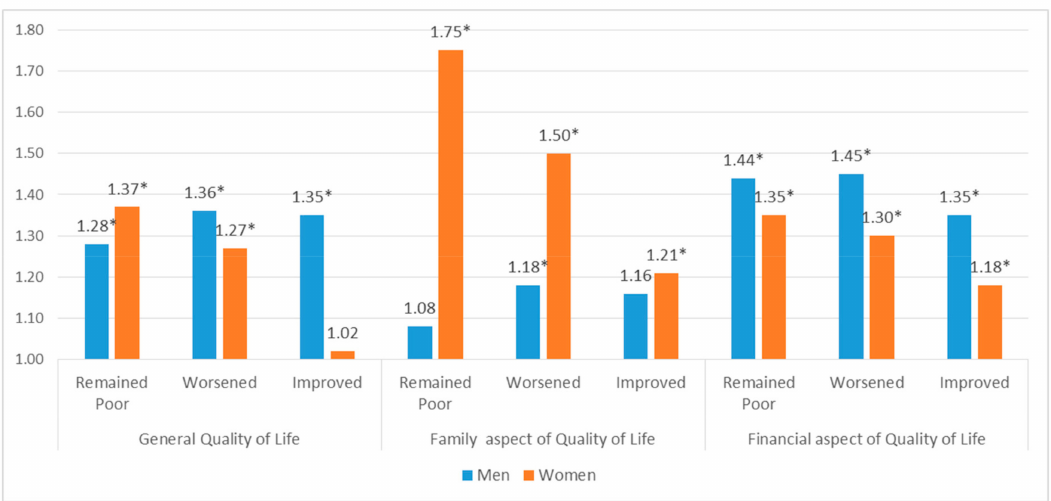
Figure 1. Subgroup analysis on gender: qualitive life with low cognitive function † measured by MMSE ‡ score. † Low: MMSE ≤ 23, normal: 24 ≤ MMSE; ‡ Mini- Mental State Examination (MMSE); * Statistically significant value.